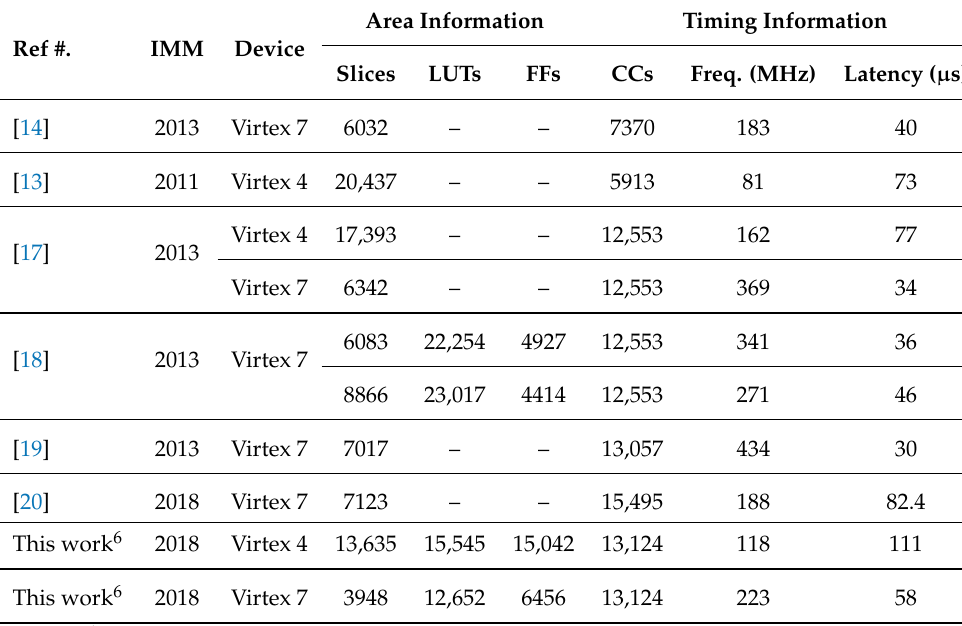
Table 6. Comparisons to state-of-the-art implementations over GF ( 2 233 ) .